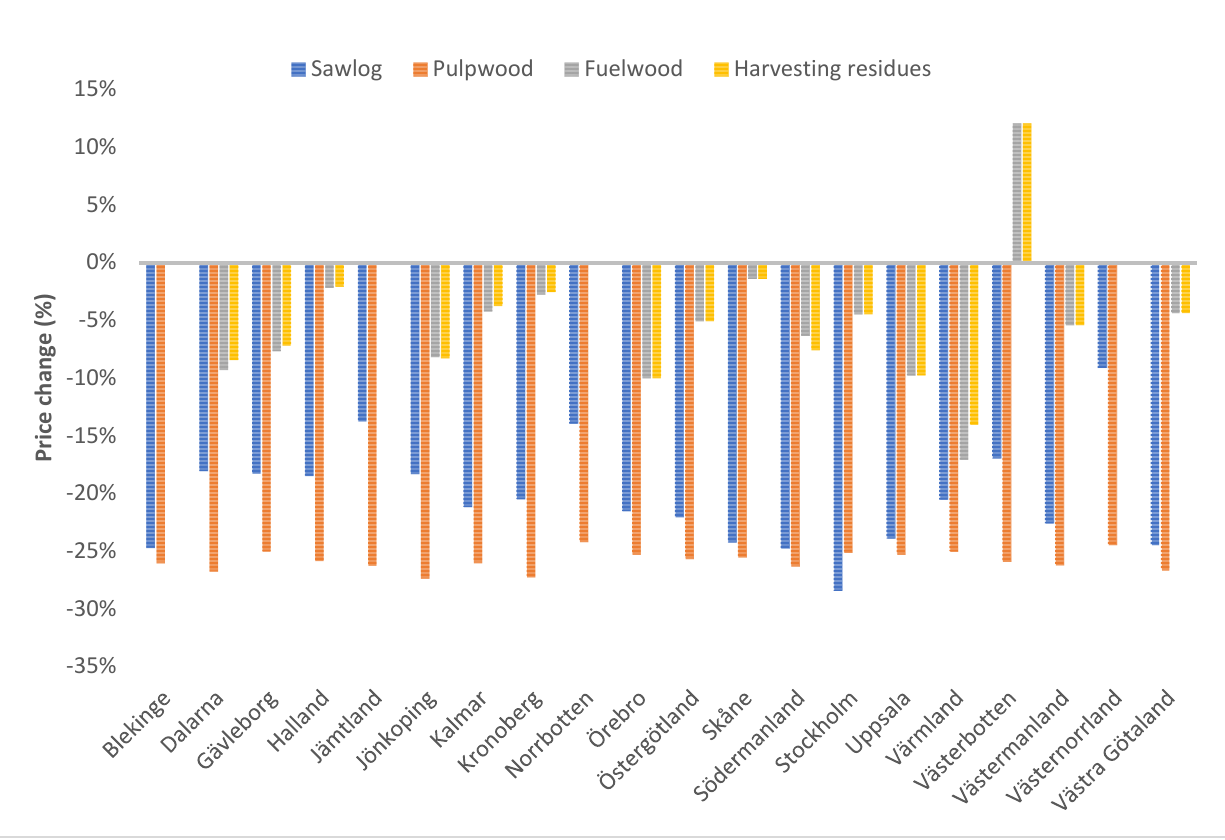
Figure 3. Price effects from more efficient harvesting operations by county.